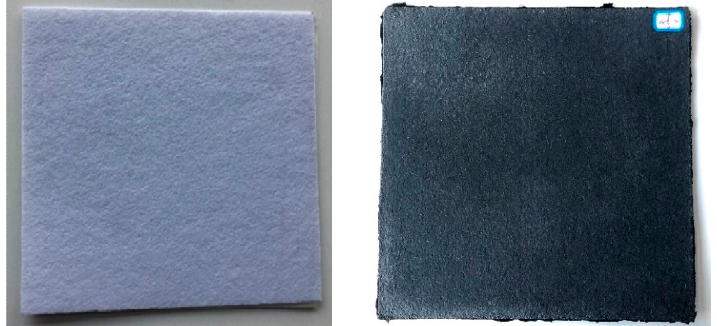
Figure 3. Physical images: ( a ) PET needle punched nonwoven fabric; ( b ) Microwave-absorbing impregnated nonwoven fabric.